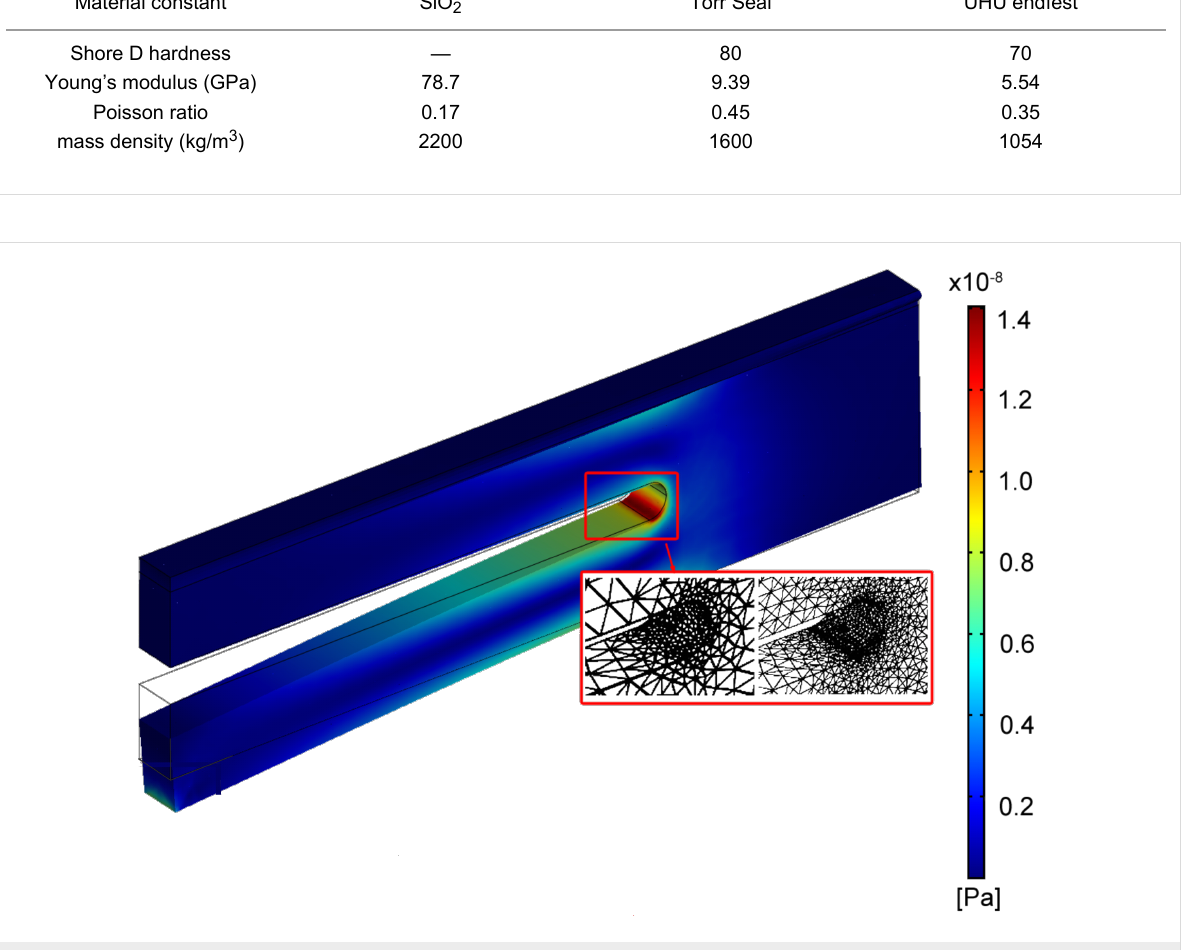
Figure 6: FEM simulation of a deflected TF. The stress is given by the color scale. The inset (red box) shows the refinement of the mesh in the stressed